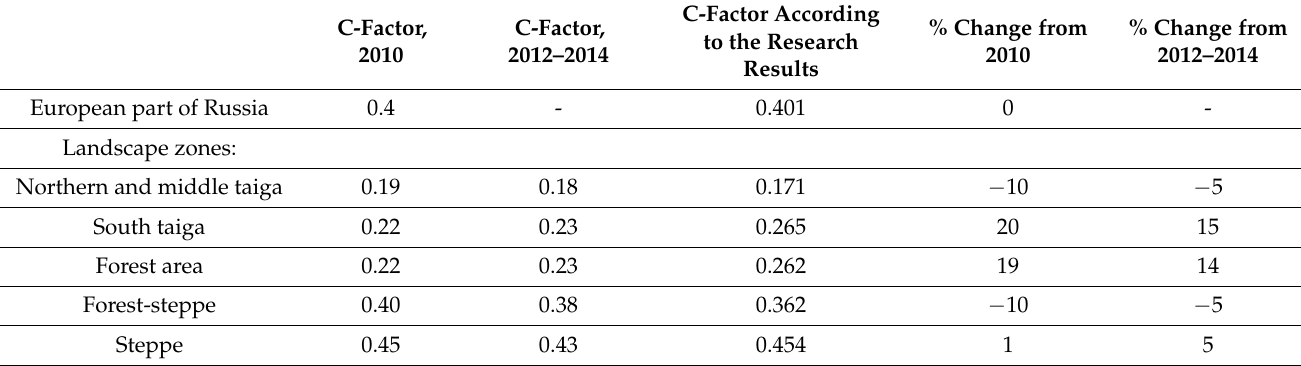
Table 6. C-factor on arable land according to literature data [5,51] and according to the results of the study.